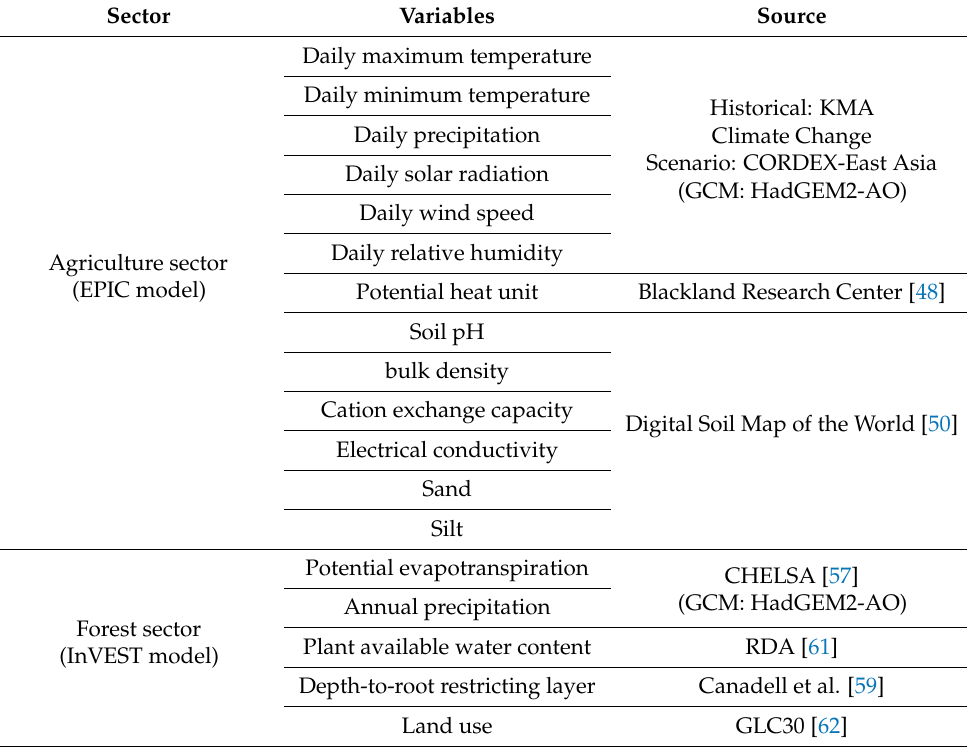
Table 1. Input variables used for each